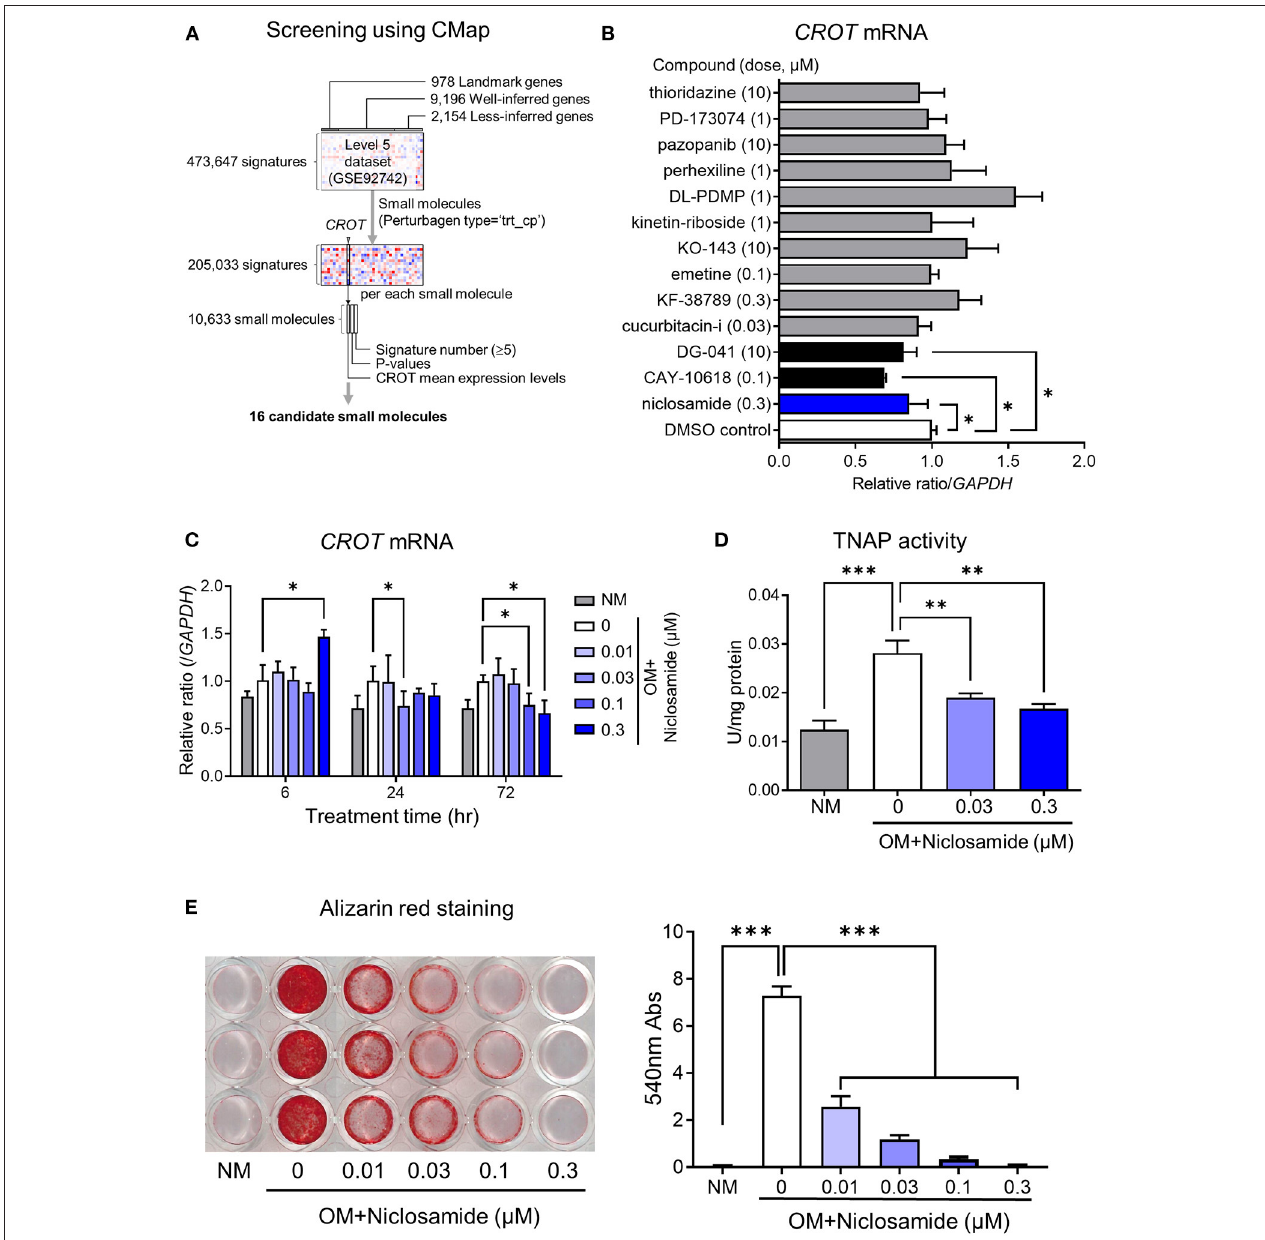
FIGURE 1 | In silico screening and in vitro validation of candidate small molecule inhibitors of CROT expression and calcification in hSMCs. (A) Flowchart of candidate small molecule selection using connectivity map (CMap) with L1000 database. Small molecules “pert_type” = “trt_cp” extracted from all perturbagens in L1000. (B) The effects of candidate compounds on CROT (carnitine O-octanoyltransferase) transcript levels in hSMCs cultured in osteogenic media. The µ M concentrations are listed. (C) CROT transcript levels in SMCs at 6-, 24-, and 72-h treatment with niclosamide. (D) TNAP (tissue-non-specific alkaline phosphatase) activity in hSMCs treated with niclosamide for 14 days. (E) Alizarin red staining and quantification in hSMCs treated with Niclosamide for 21 days. Data were analyzed by ANOVA with Dunnett’s multiple comparison test, * P < 0.05, ** P < 0.01, *** P < 0.001. (C,D) Each panel present data from the same donor, with three technical replicates. Error bars are mean ±